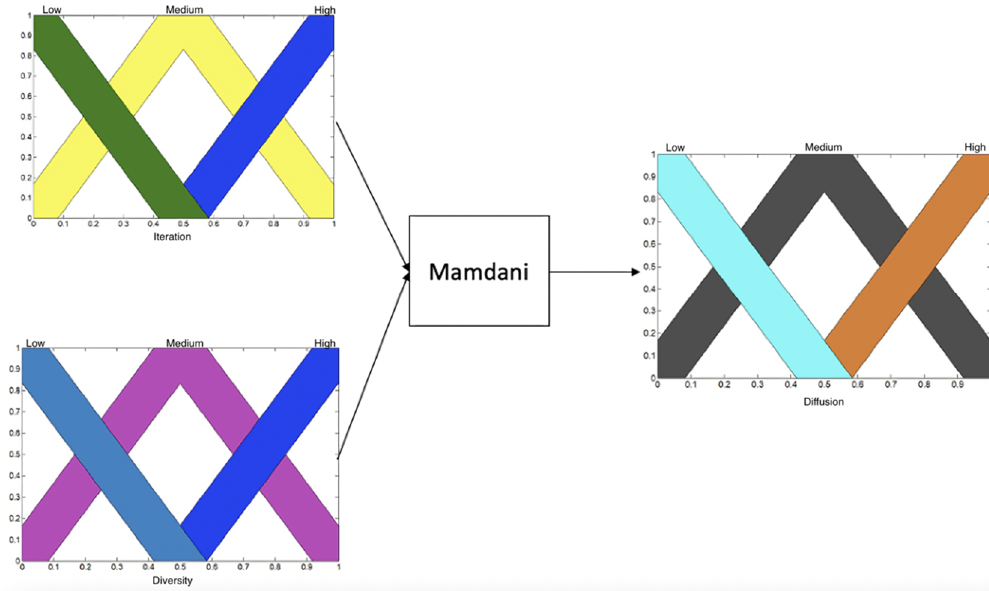
Figure 2. Type-2 fuzzy system for controlling the diffusion .